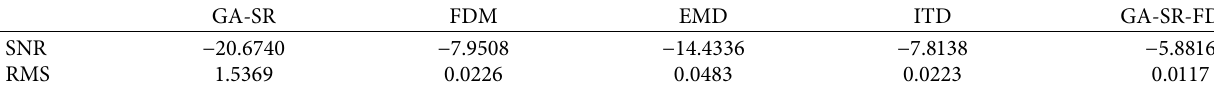
Figure 2: Waveform and frequency spectrum of the simulation signal processed by different methods. (a) Unprocessed simulated signal. (b) Simulated signal processed by GA-SR. (c) Simulated signal processed by FDM. (d) Simulated signal processed by EMD. (e) Simulated signal processed by ITD. (f) Fault signal and simulated signal processed by GA-SR-FDM. Table 1: Performance comparison of each method.